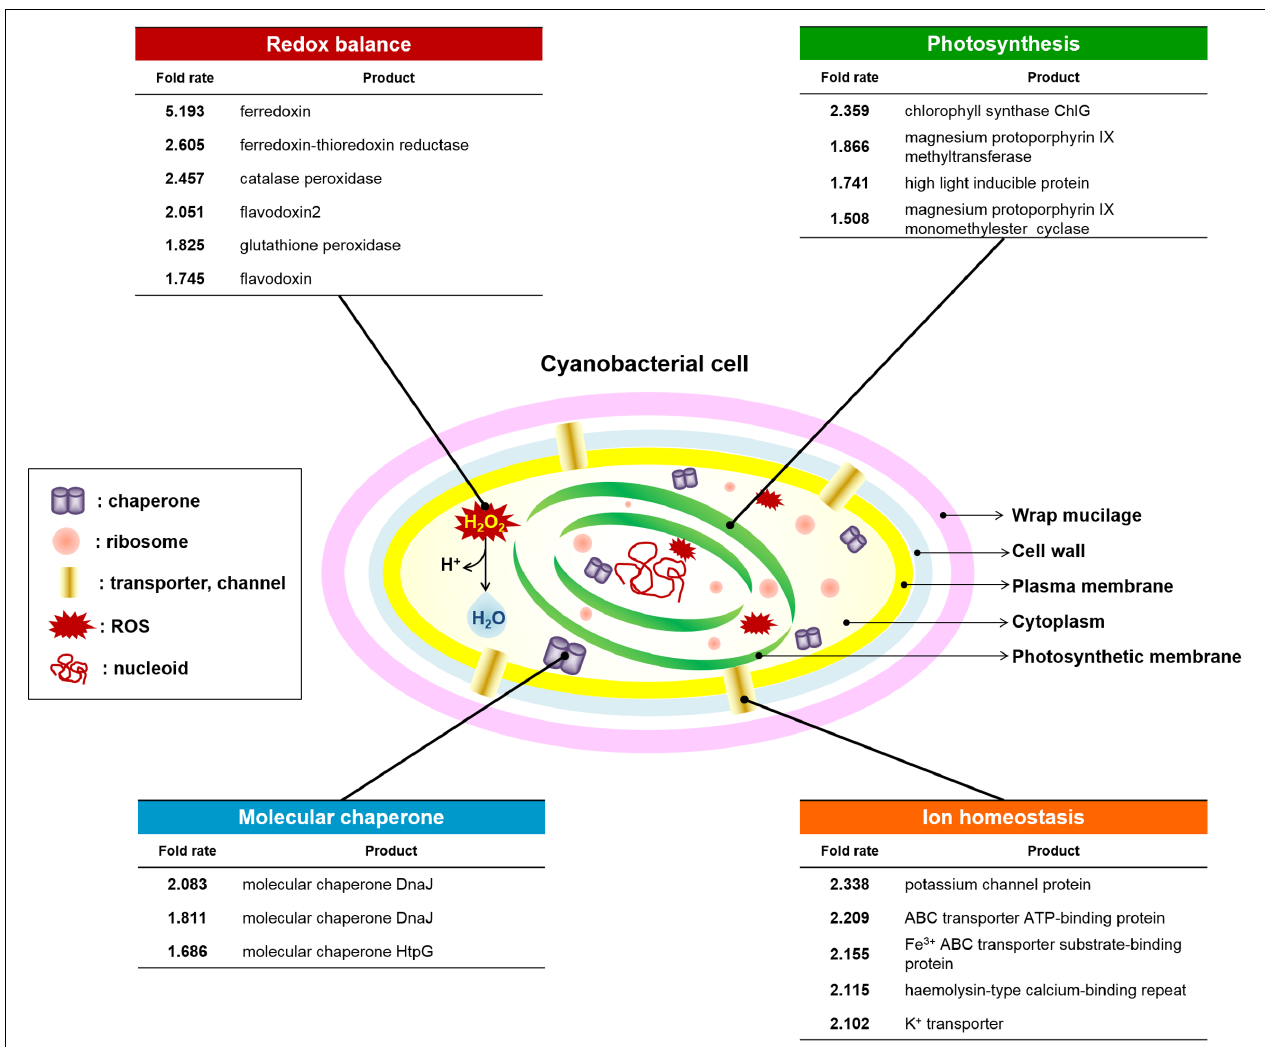
FIGURE 7 | Changes in cyanobacterial defense system against ROS-induced oxidative stress. Redox balance (six genes), photosynthesis (four genes), Molecular chaperone (three genes), and ion homeostasis (five genes) were upregulated in OT strain under the H 2 O 2 stress compared to the WT. Statistically significant changes indicate a fold-change, provided by e-biogen RNA-Seq Service Company (http://www.e-biogen.com). Detailed data about RNA-Seq analysis are presented in Supplementary Tables S5